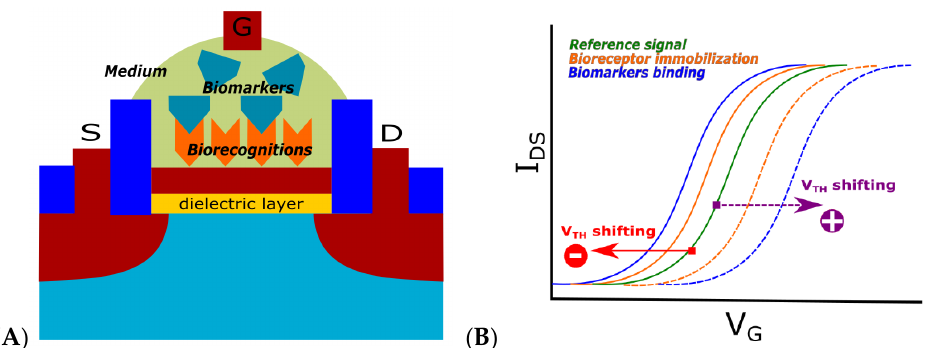
Figure 2. ( A ) A typical FET-based biosensor that utilizes the gate as a sensing layer. The biorecognition elements and biomarkers are in the medium solution, while the gate voltage is supplied from an electrode in contact with the medium. ( B ) The shifting of the threshold voltage (V TH ) characteristics in the presence of charge accumulation from biomolecular adsorption in the sensing